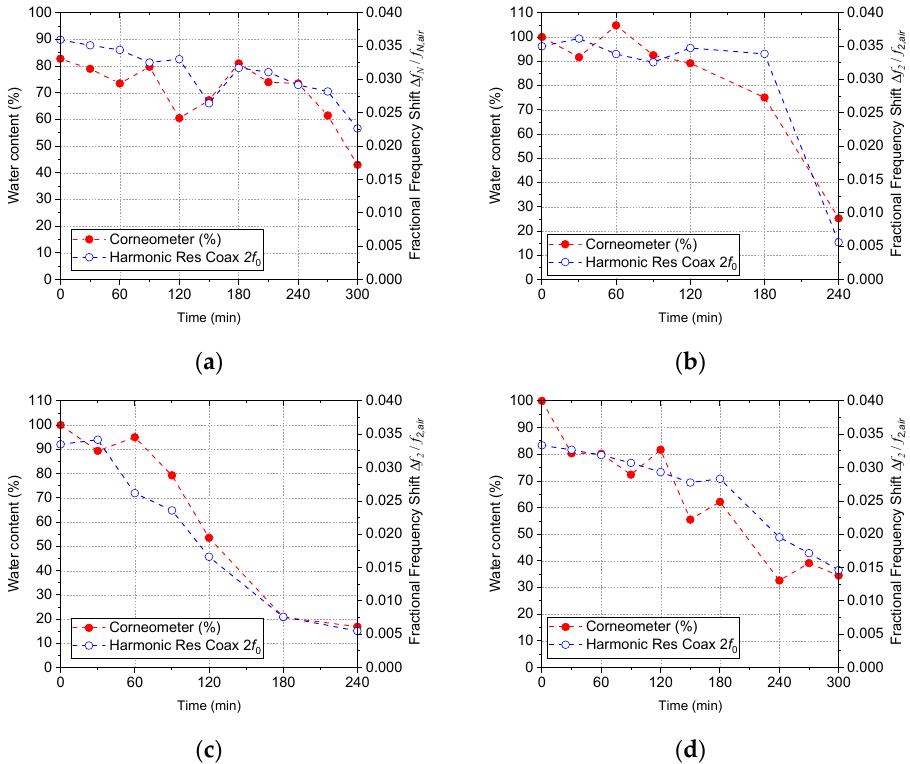
Figure 10. Water content over time measured by Corneometer and fractional frequency shift measured by the proposed harmonic resonance coaxial probe at 2nd harmonic frequency, ( a ) cervical sample A (030215), ( b ) cervical sample B (DT6070), ( c ) cervical sample C (WE4388), and ( d ) cervical sample D (180316).